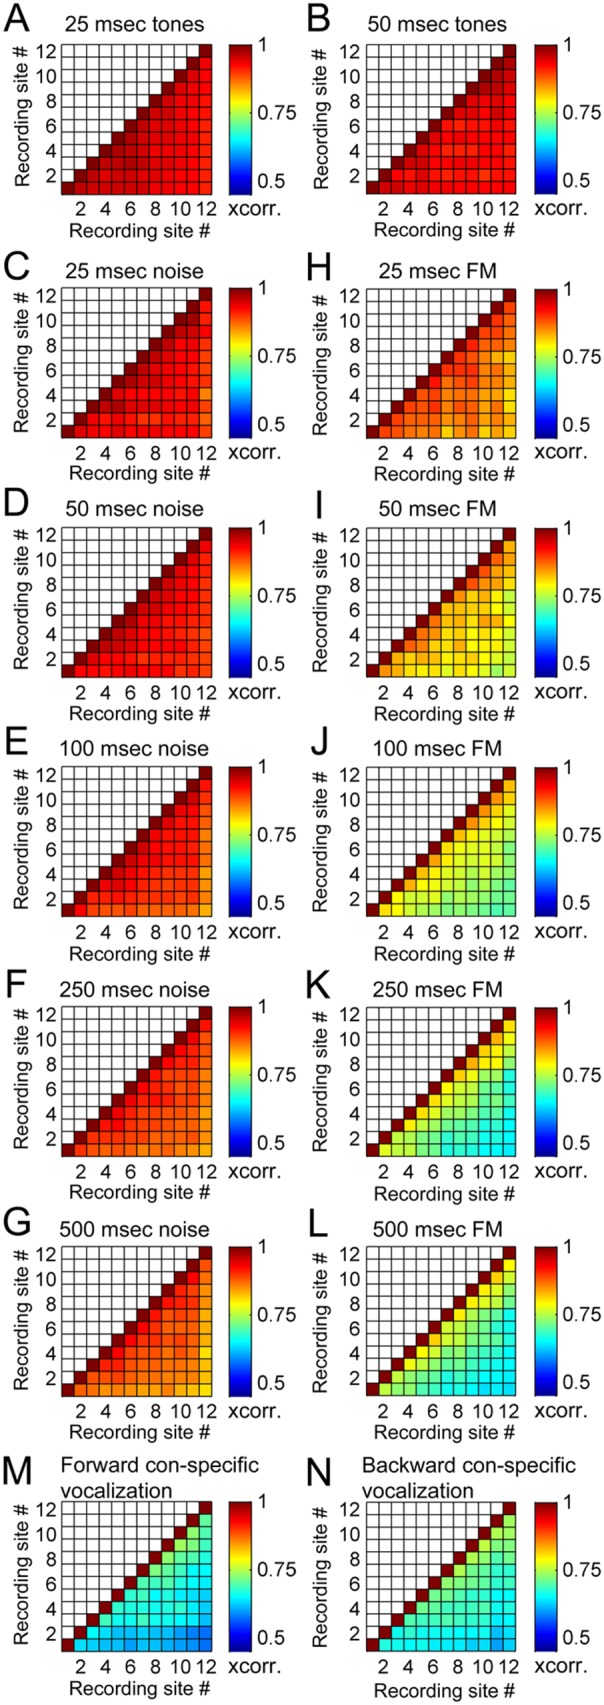
Mean response similarity index (cross-correlation value at time-lag zero) between neuronal recordings within primary auditory cortex columns.
A–B. Response similarity indices during pure tone exposure. 25-ms (A), and 50-ms (B). C–G. Response similarity indices during white noise burst exposure. 25-ms (C), 50-ms (D) 100-ms (E), 250-ms (F), and 500-ms (G). H–L. Response similarity indices during upward FM sweep exposure. 25-ms (H), 50-ms (I) 100-ms (J), 250-ms (K), and 500-ms (L). M–N. Response similarity indices during con-specific vocalization. Forward (M), time-reversed (N). Note the progressive increase in dissimilarity between responses as a function of acoustic signal duration. Similarity indices varied between ∼0.05 and 1, with an index value of 1 corresponding to comparisons of identical responses (diagonal) and an index value of 0.05 representing the largest discrepancies in response profiles measured. Numbers in color table axes correspond to recording site numbers, see Fig. 1 for electrode site description.